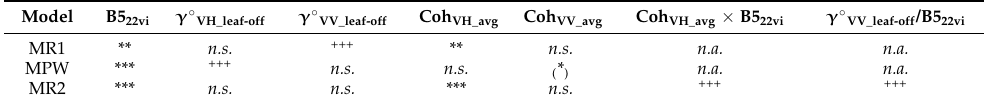
Table 6. Significance of the coefficient (predictors) in AGB